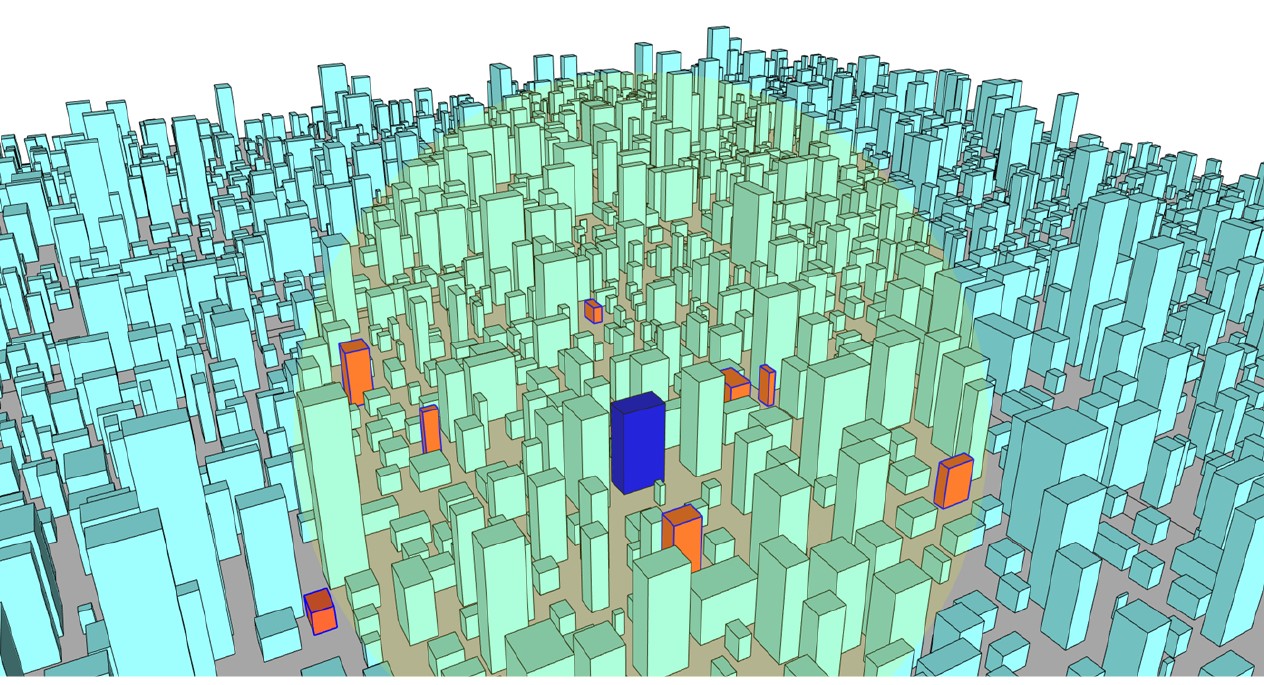
Figure 6. Location of competitors from point q within